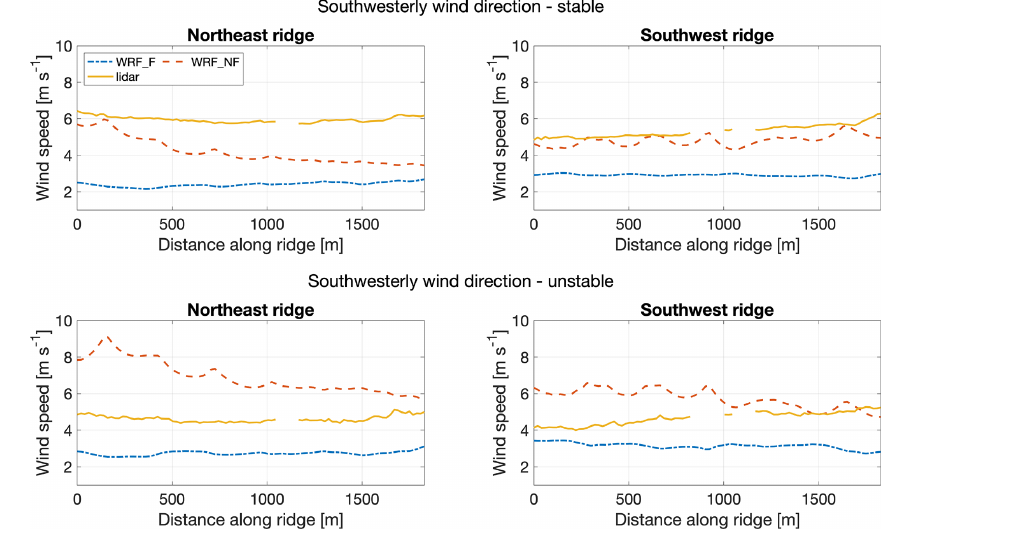
Figure 6. Comparison of WRF wind speeds and lidar ridge scan measurements for southwesterly flow, segregated into stable and unstable